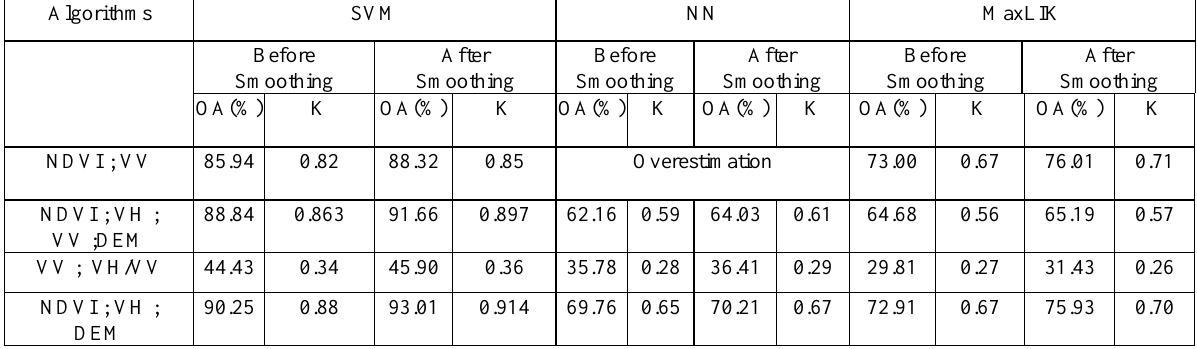
Table 3 . Improvement of the global accuracies and Kappa indices by applying of smoothing.